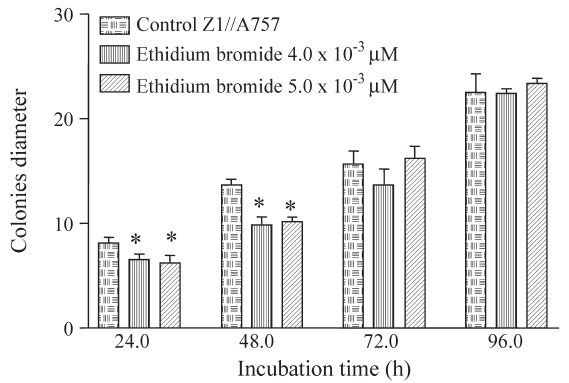
Figure 3 - Growth of diploid Z1//A757 in CM + 4.0 x 10 -3 µ M and CM